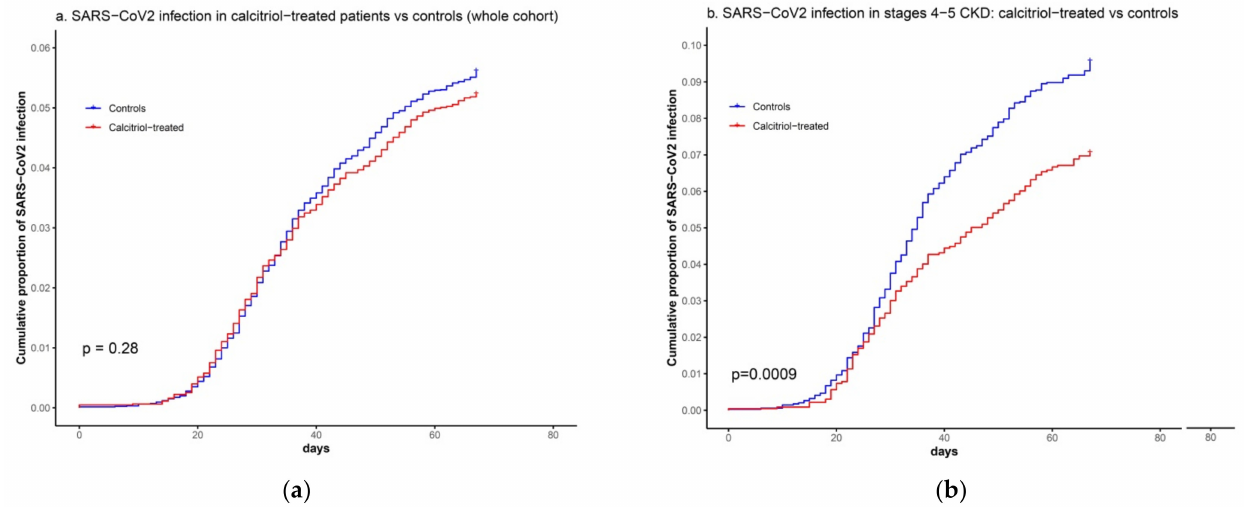
Figure 1. Kaplan–Meier plots showing ( a ) the cumulative proportion of patients with SARS-CoV2 infection between 25 February 2020 and 30 April 2020 in calcitriol-treated patients and matched controls (whole cohort); and ( b ) the cumulative proportion of SARS-CoV2 infection in patients in stages 4 or 5 CKD treated with calcitriol versus untreated controls. Mean daily calcitriol dose in 5885 subjects supplemented from November 2019 to Febru- ary 2020 was 264.9 µ g/day (SD 217.5). Neither univariate nor multivariate Cox